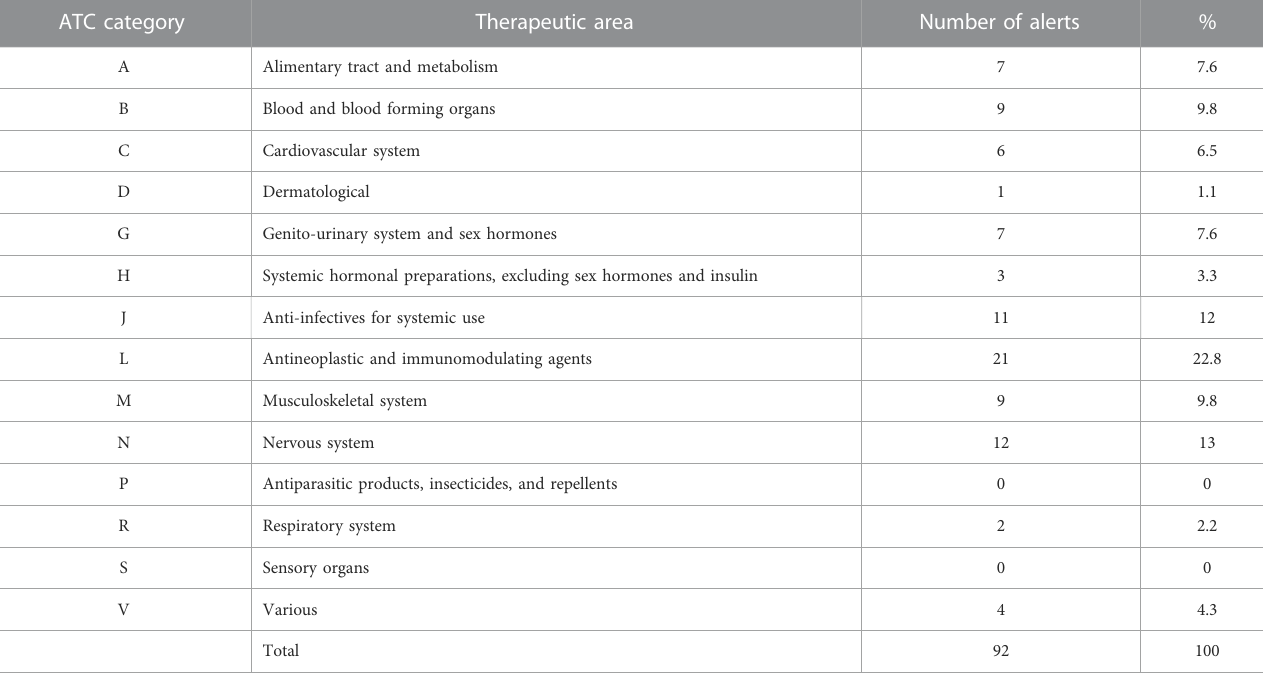
TABLE 3 Anatomical Therapeutic Chemical (ATC) drug classi fi cation system. ATC